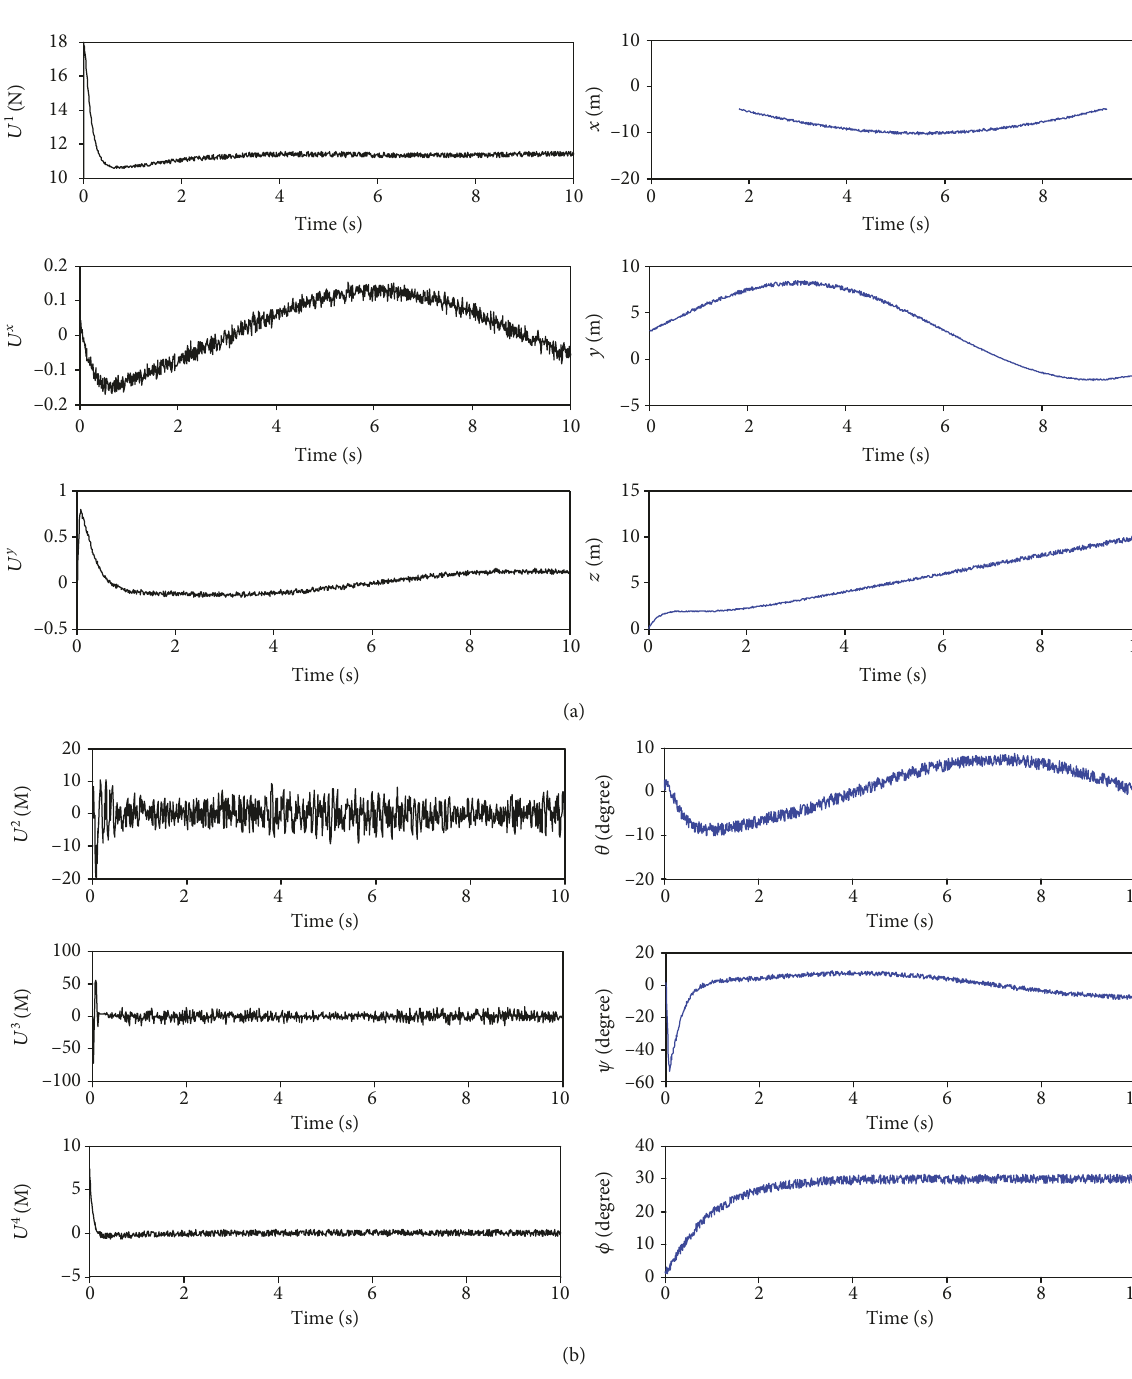
Figure 8: One sample of the training data sets: (a) control inputs and system outputs of translation subsystem; (b) control inputs and system outputs of the rotation